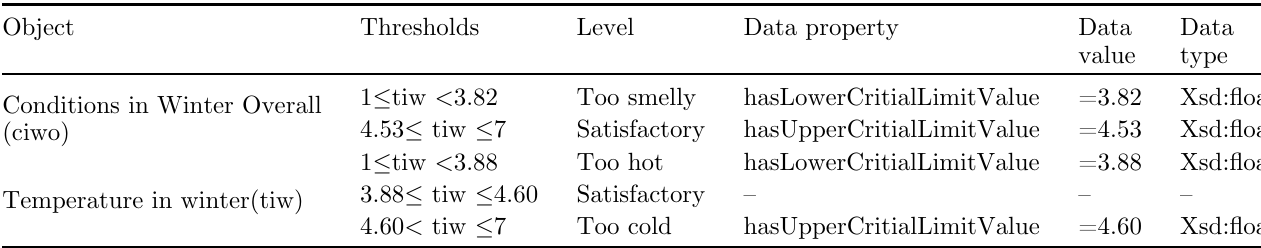
Table 5. The OWL properties.